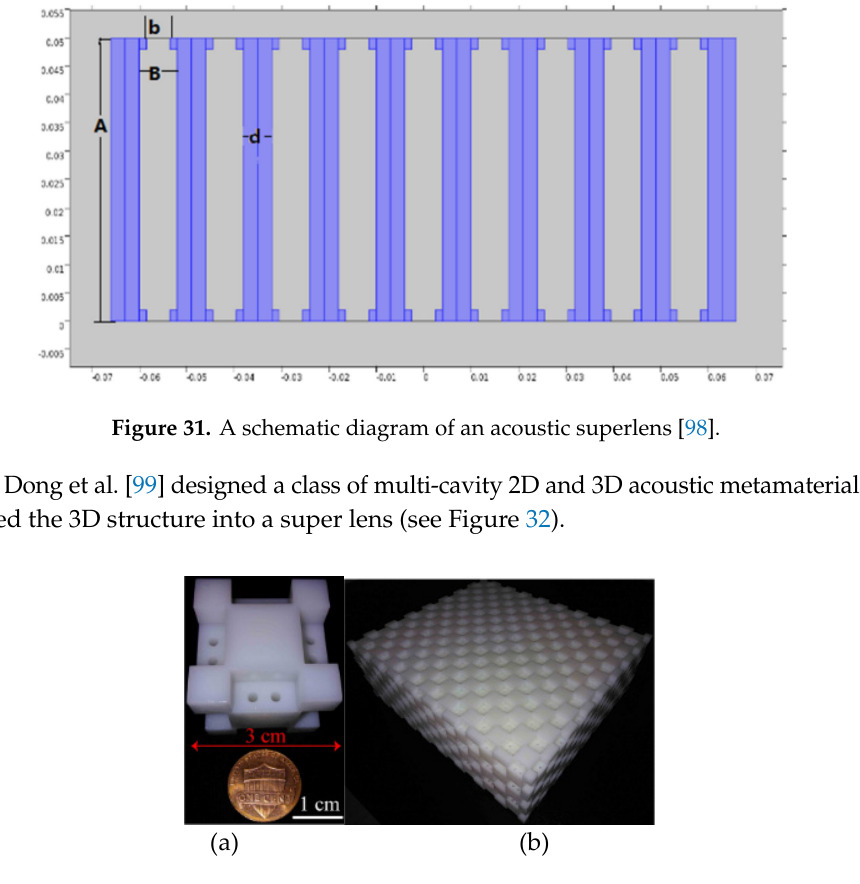
Figure 32. ( a ) Fabricated 3D microstructure sample; ( b ) Photograph of a 3D superlens containing 8 × 9 × 3 microstructures [99].